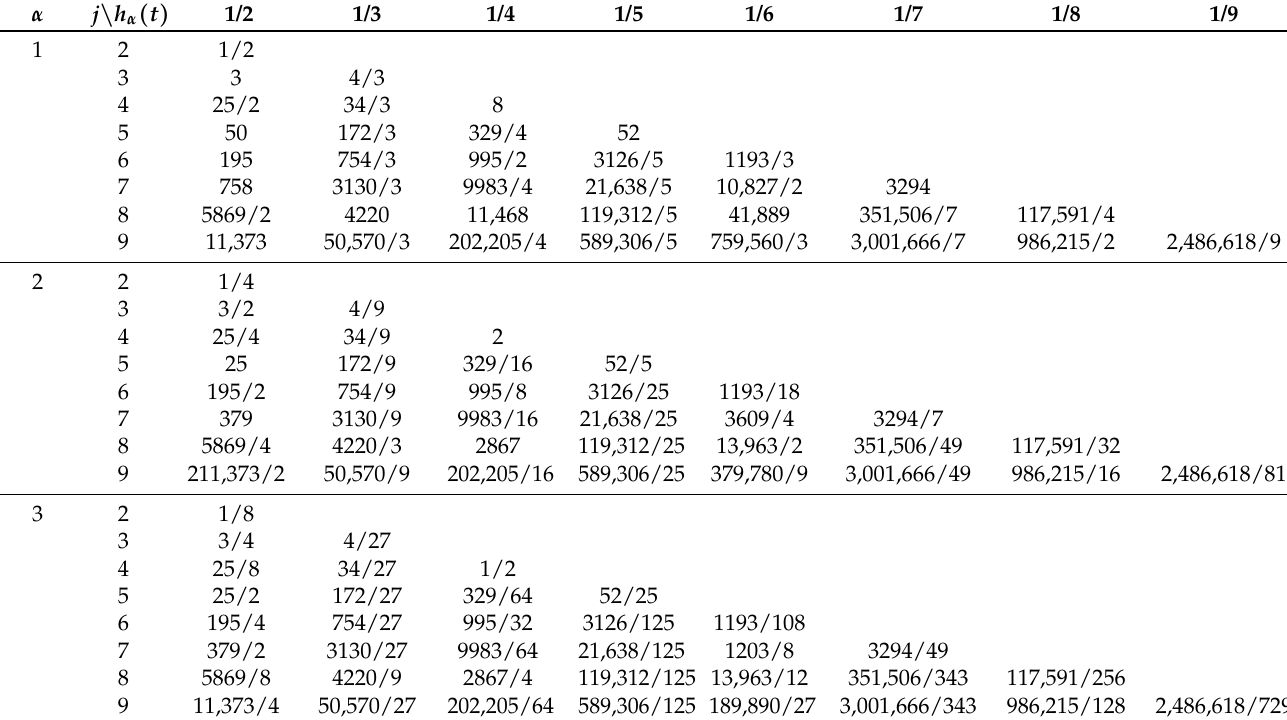
Table 3. Energy values of codes C Γ j , 2 α 9 , 1 3. } ≤ ≤